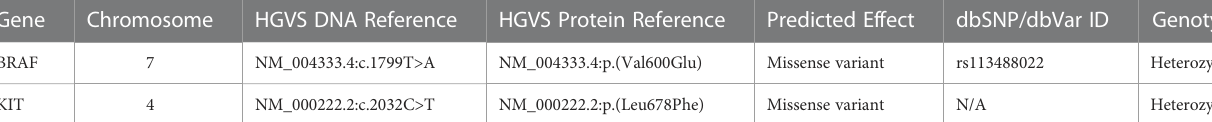
TABLE 1 Genetic variants identi fi ed using next generation sequencing.